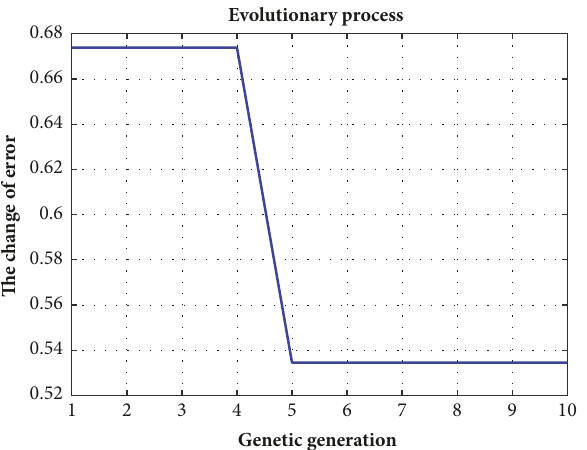
Figure 9: Classification target visualization.